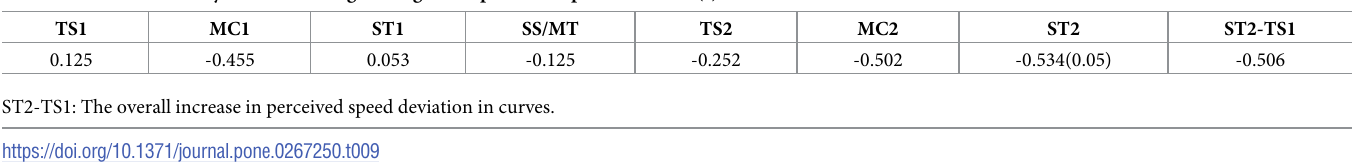
Table 9. Correlation analysis between tangent length and perceived speed deviation (r).